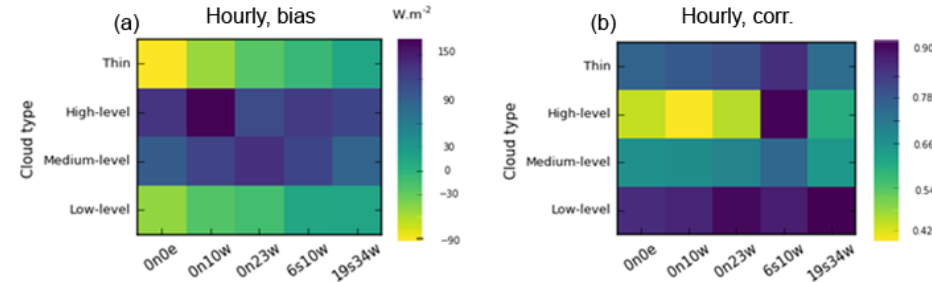
Figure 9. Bias ( a , in Wm − 2 ) and correlation coefficient (b) as a function of the cloud type at each PIRATA buoy for MERRA-2.